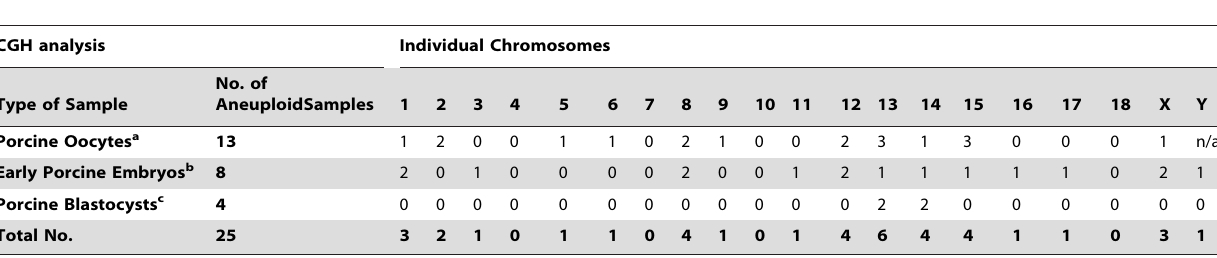
Table 3. The occurrence of individual pig chromosomes in aneuploid oocytes, early embryos and blastocysts.